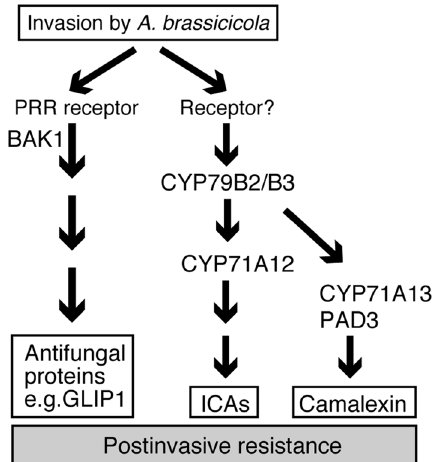
Figure 7. Summarized model for Arabidopsis postinvasive resistance against Ab . The CYP71A12-dependent production of ICAs is required for postinvasive resistance against A. brassicicola . The CYP71A13- and PAD3- dependent production of camalexin is also required for postinvasive resistance against Ab . The bak1 mutations (especially bak1-5 ) reduced the postinvasive resistance, however, invasion-triggered activation of these Trp- related pathways is not canceled by bak1-5 . The bak1-5 sensitive pathway control the expression of antifungal protein genes (e.g. GLIP1